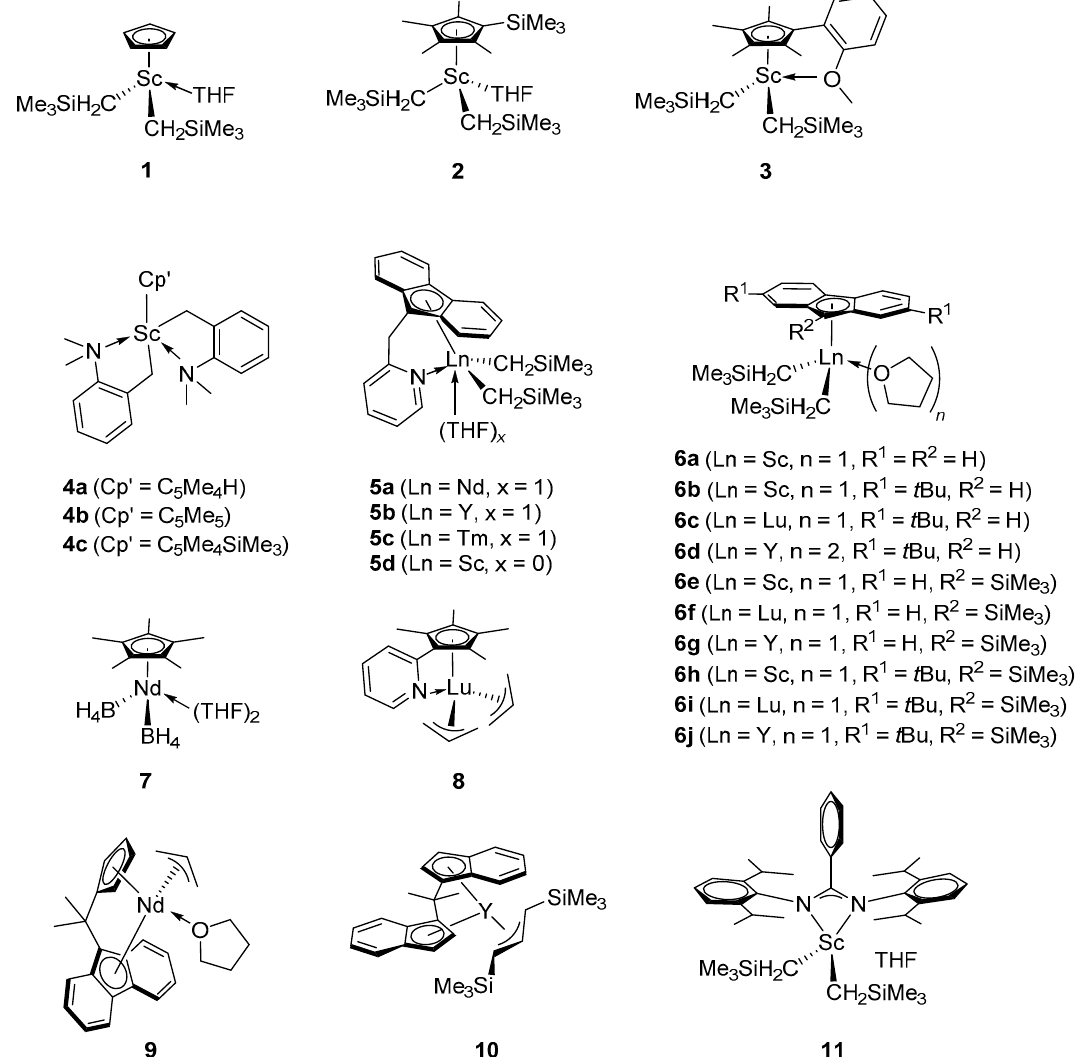
Figure 1. Group 3 metal catalyst precursors used for stereoselective styrene copolymerizations.